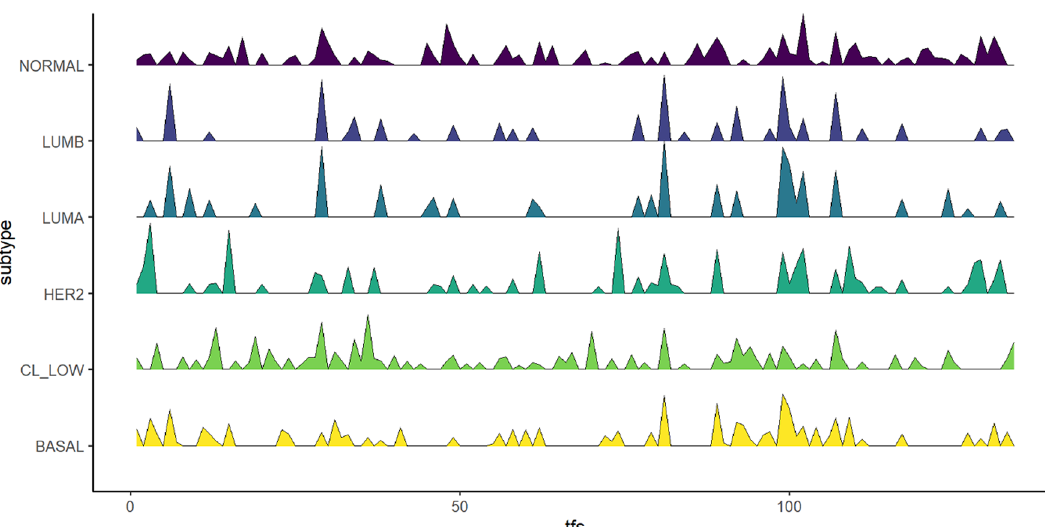
Figure 5. Closeness Centralities of Breast Cancer Subtypes. The peaks correspond to the closeness centrality of different TFs among the subtypes. The results show that breast cancer subtypes have differences in their underlying